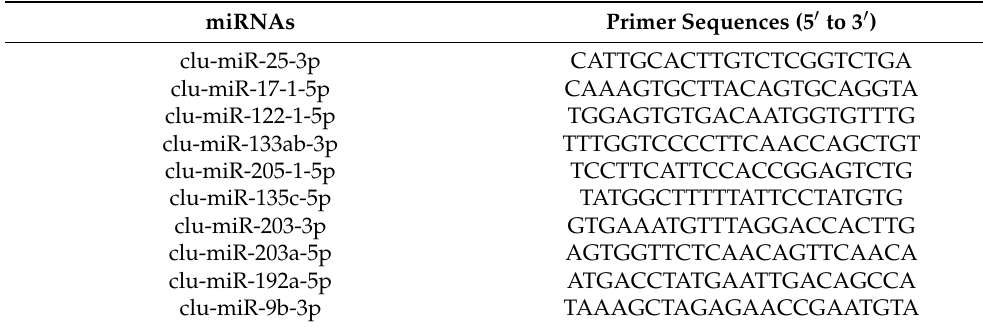
Table 1. Primers used in qPCR analysis of mature